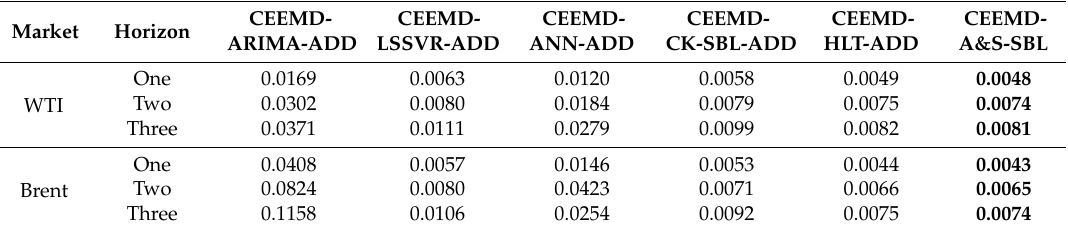
Table 3. The mean absolute percent error (MAPE) values of different prediction models on WTI and Brent crude oil